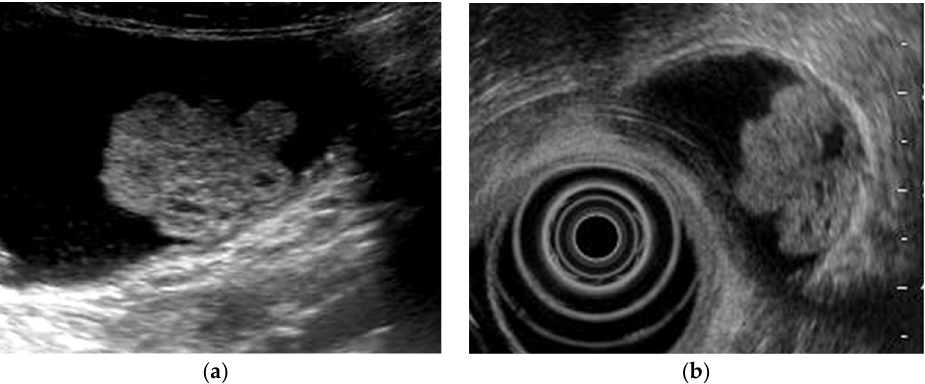
Figure 6. Cystic structures (anechoic spots) corresponding to cystically dilated cancerous glands. ( a ) High-frequency transducer (8 MHz) and ( b ) EUS (12 MHz) showed irregularly shaped cystic lesions of various sizes corresponding to cystically dilated cancerous glands (GBC concomitant with pancreatobiliary maljunction case) .